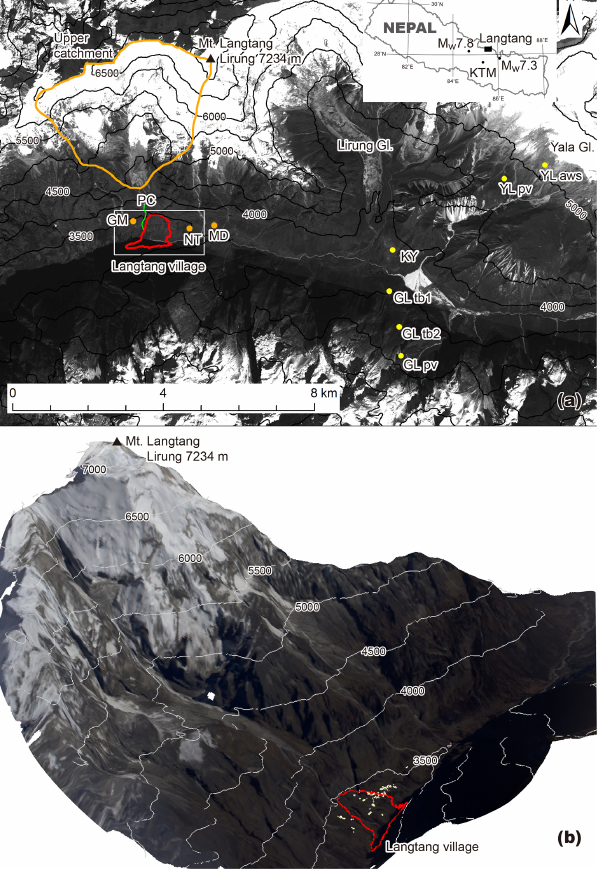
Figure 1. (a) Overview and (b) 3-D view of the Langtang village surveyed in this study. (a) Area of Figs. 2 and 5 (white polygon), debris covering the village (red polygon), upper catchment from which the avalanche could have originated (orange polygon), other villages mentioned in the text (orange circles), small gorge (green line), and locations where meteorological stations are located (yel- low circles) in the valley (valley location shown in inset panel) are depicted. (b) Debris cover (red polygon) and village facility (flesh polygons) are depicted on the 3-D image including Mount Langtang Lirung. The background image of (b) is created from oblique aerial photographs taken in December 2007. Built-up areas of the village are delineated from the ALOS PRISM image, which is the back- ground of (a) , taken on 3 December 2010 before the Gorkha earth- quake. Contour lines at 500m interval are depicted with ASTER GDEM2. Abbreviations denote Gomba (GM), Pääbe Chu (PC), Numthang (NT), Mundu (MD), Kyanjin (KY), Yala (YL), Gangja La (GL), automatic weather station (aws), pluviometer (pv), and rain gauge of tipping bucket